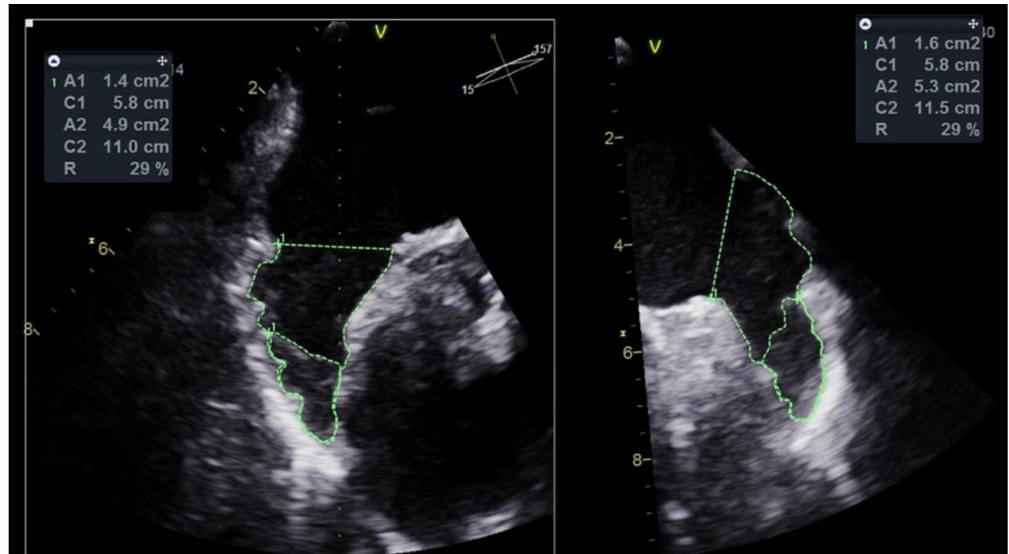
Figure 1. Measurement of percentage of left atrial appendage volume occupied by thrombus in transesophageal echocar- diography (TEE) (Supplementary Video S1). A1 and A2, Areas 1 and 2; C1 and C2, Circumferences 1 and 2; R, ratio